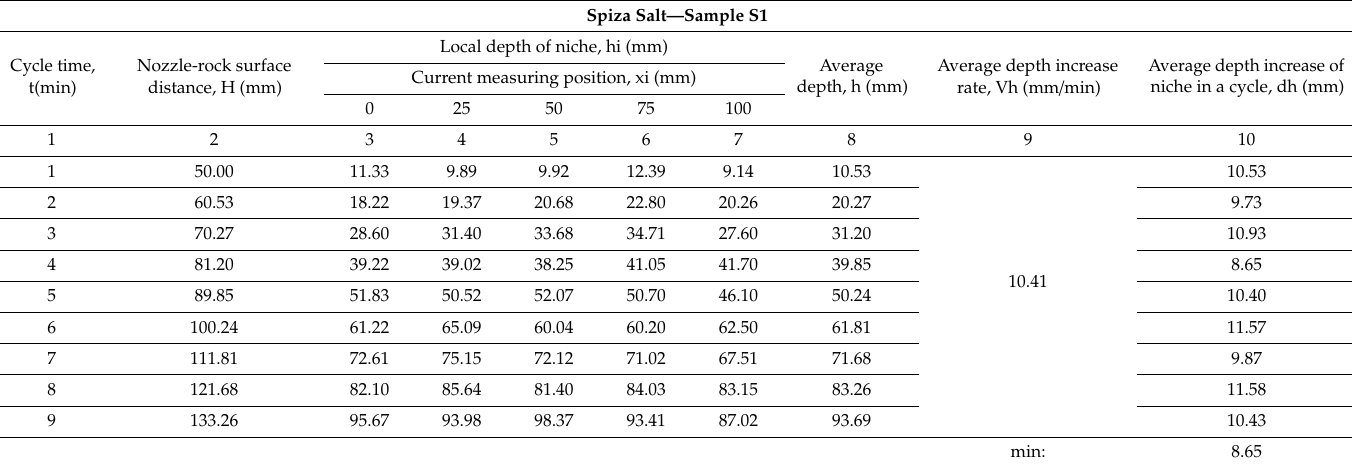
Table 4. Results of measurements of high-pressure water jet niche cutting parameters—“Spiza (bronze) salt”